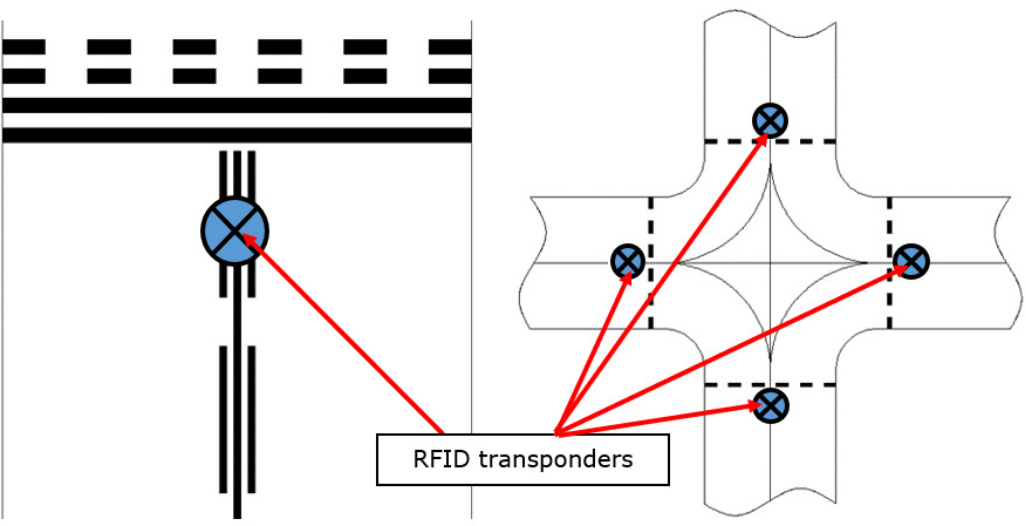
Figure 6. Examples of placing RFID transponders on the airport apron.